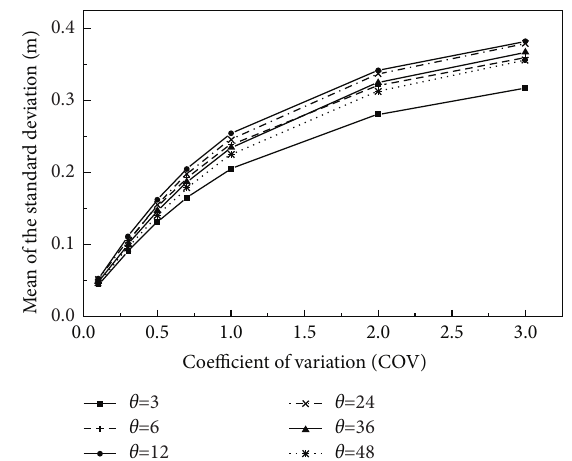
Figure 8: Mean of the total head standard deviation versus COV of the hydraulic